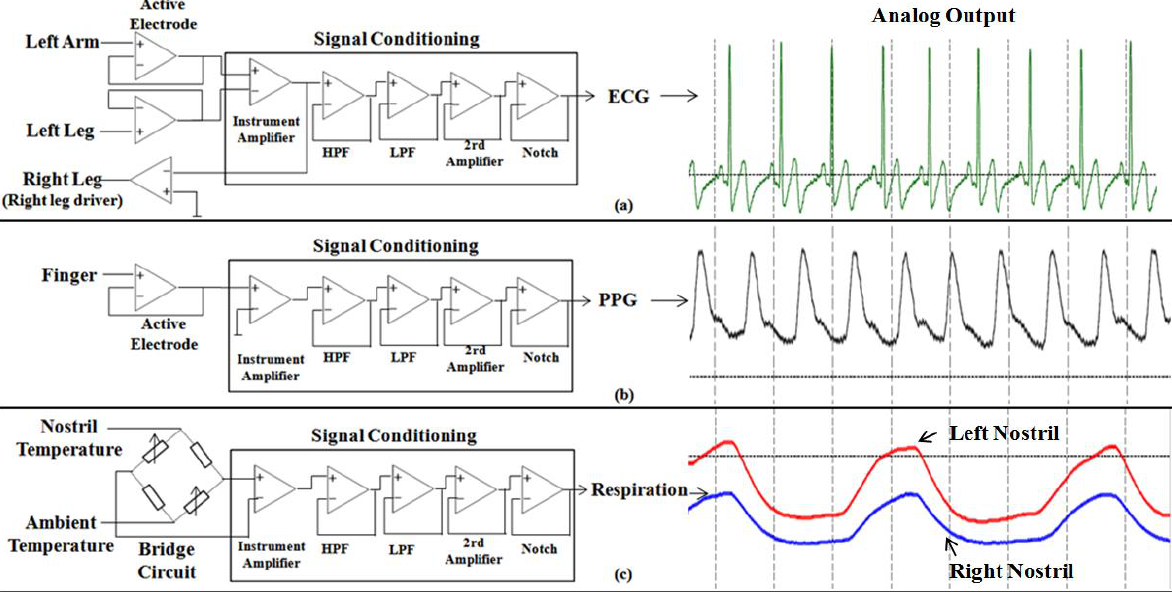
Figure 3. The structure of biosensor and corresponding analogy output; ( a ) ECG sensor; ( b ) PPG sensor; ( c ) Respiration sensor.